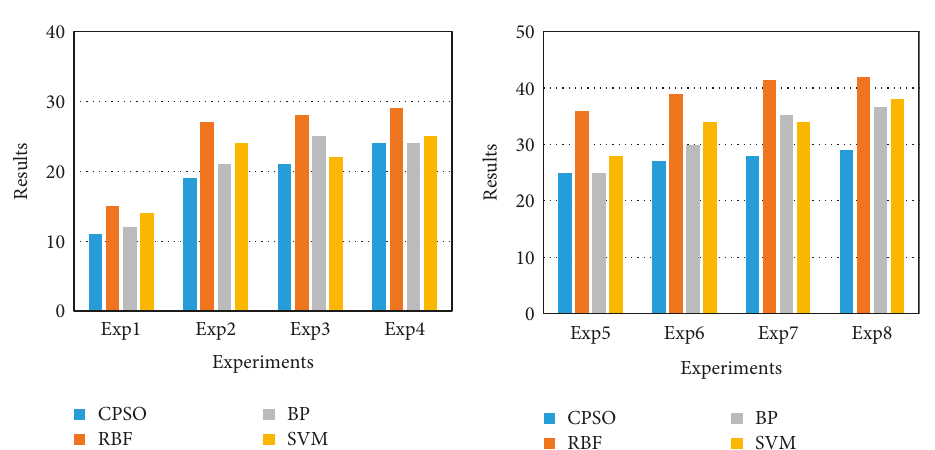
Figure 8: Stability of CNC electronic machining.